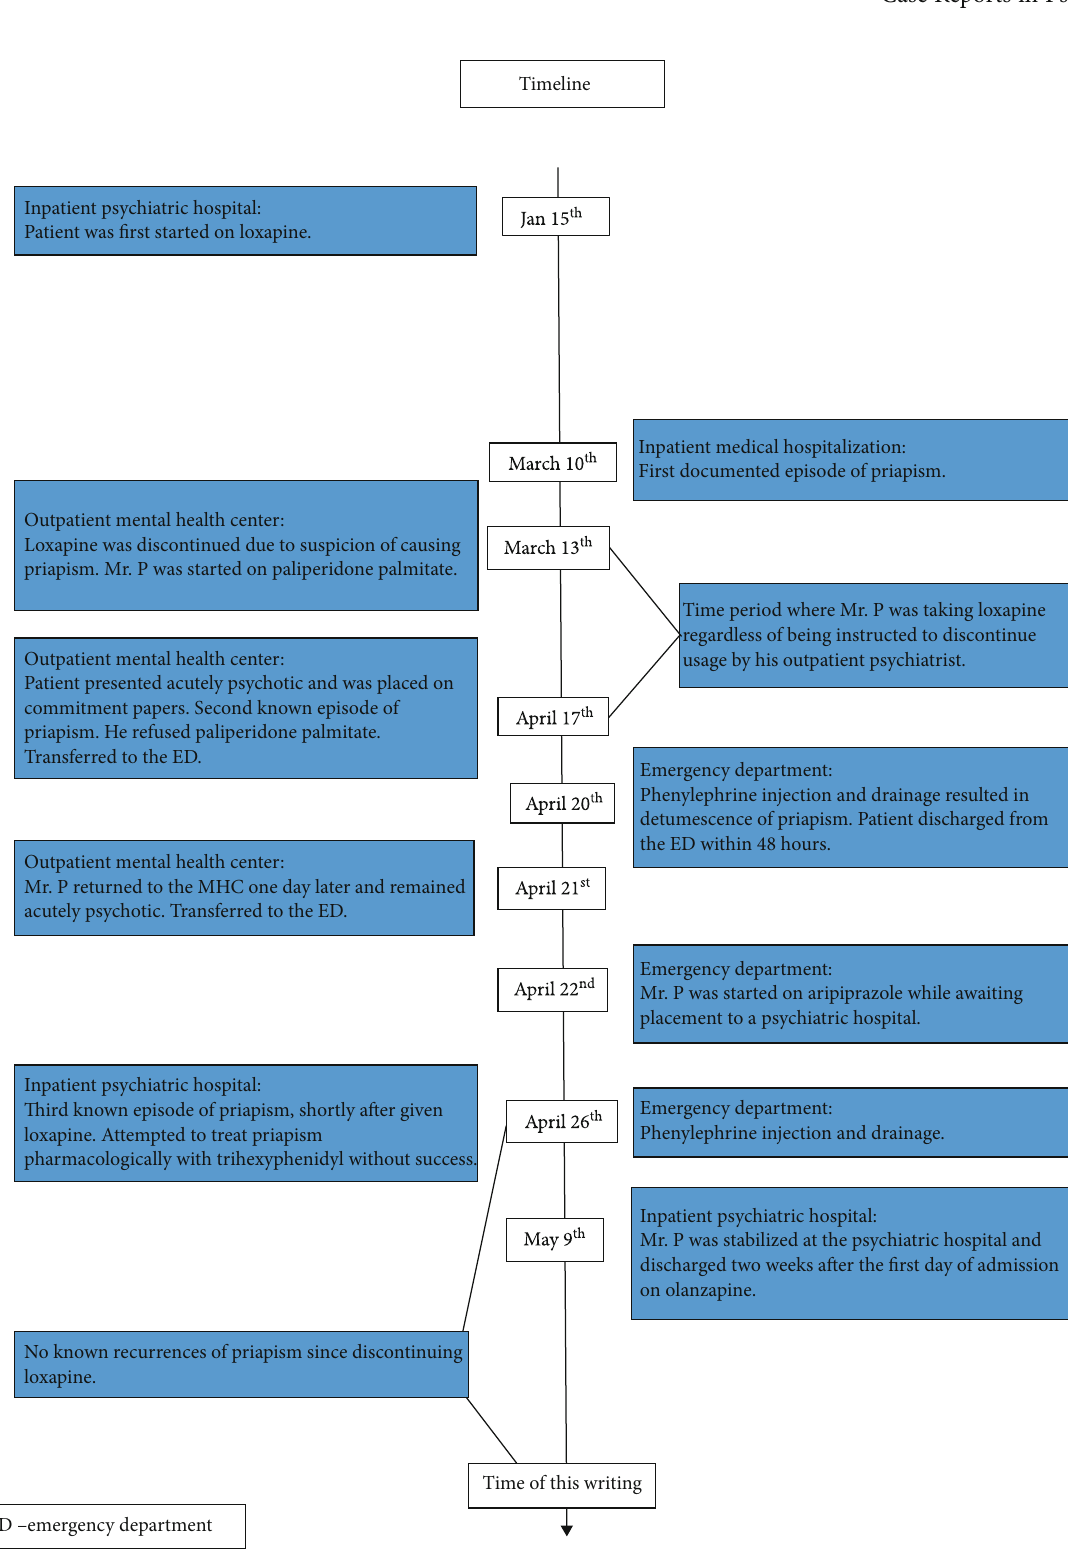
Figure 1: A timeline of events represented in the case report. ED =emergency